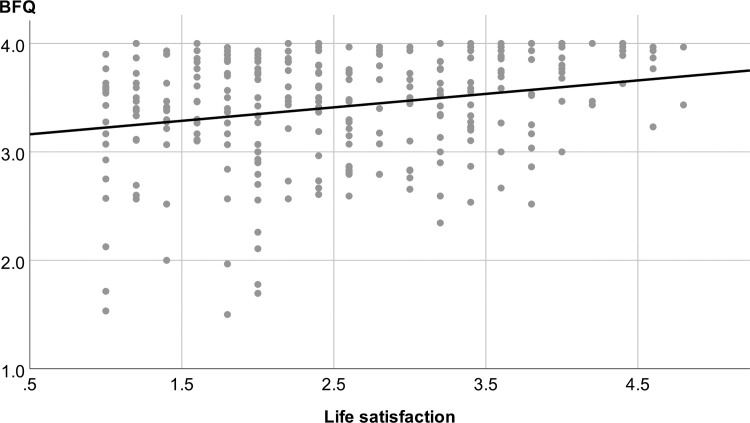
Divergent validity: The mean BFQ rating was weakly, but systematically modulated by life satisfaction, as measured by the satisfaction with life scale (SWLS, r = 0.238, p < 0.001).The BFQ scores were strongly left-skewed (most values > 3), whereas the SWLS scores tended to be right-skewed.